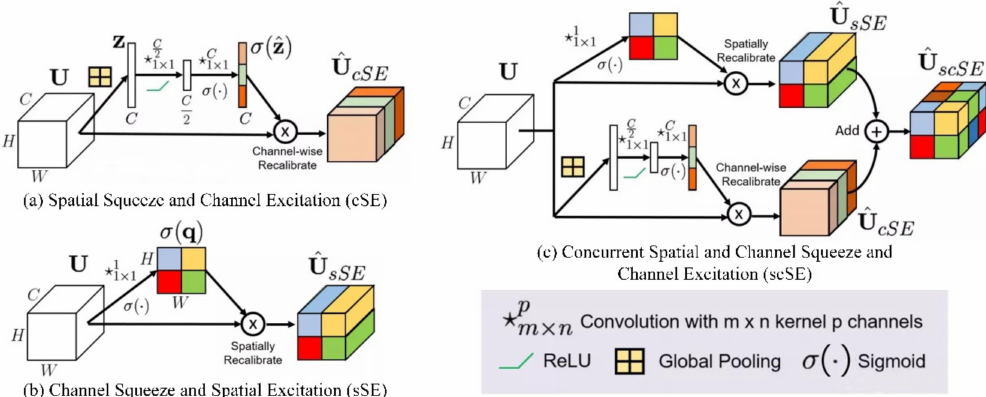
Figure 4. The structure of Squeeze and Excitation (SE) blocks. ( a – c ) are the structures of cSE, sSE, and scSE,